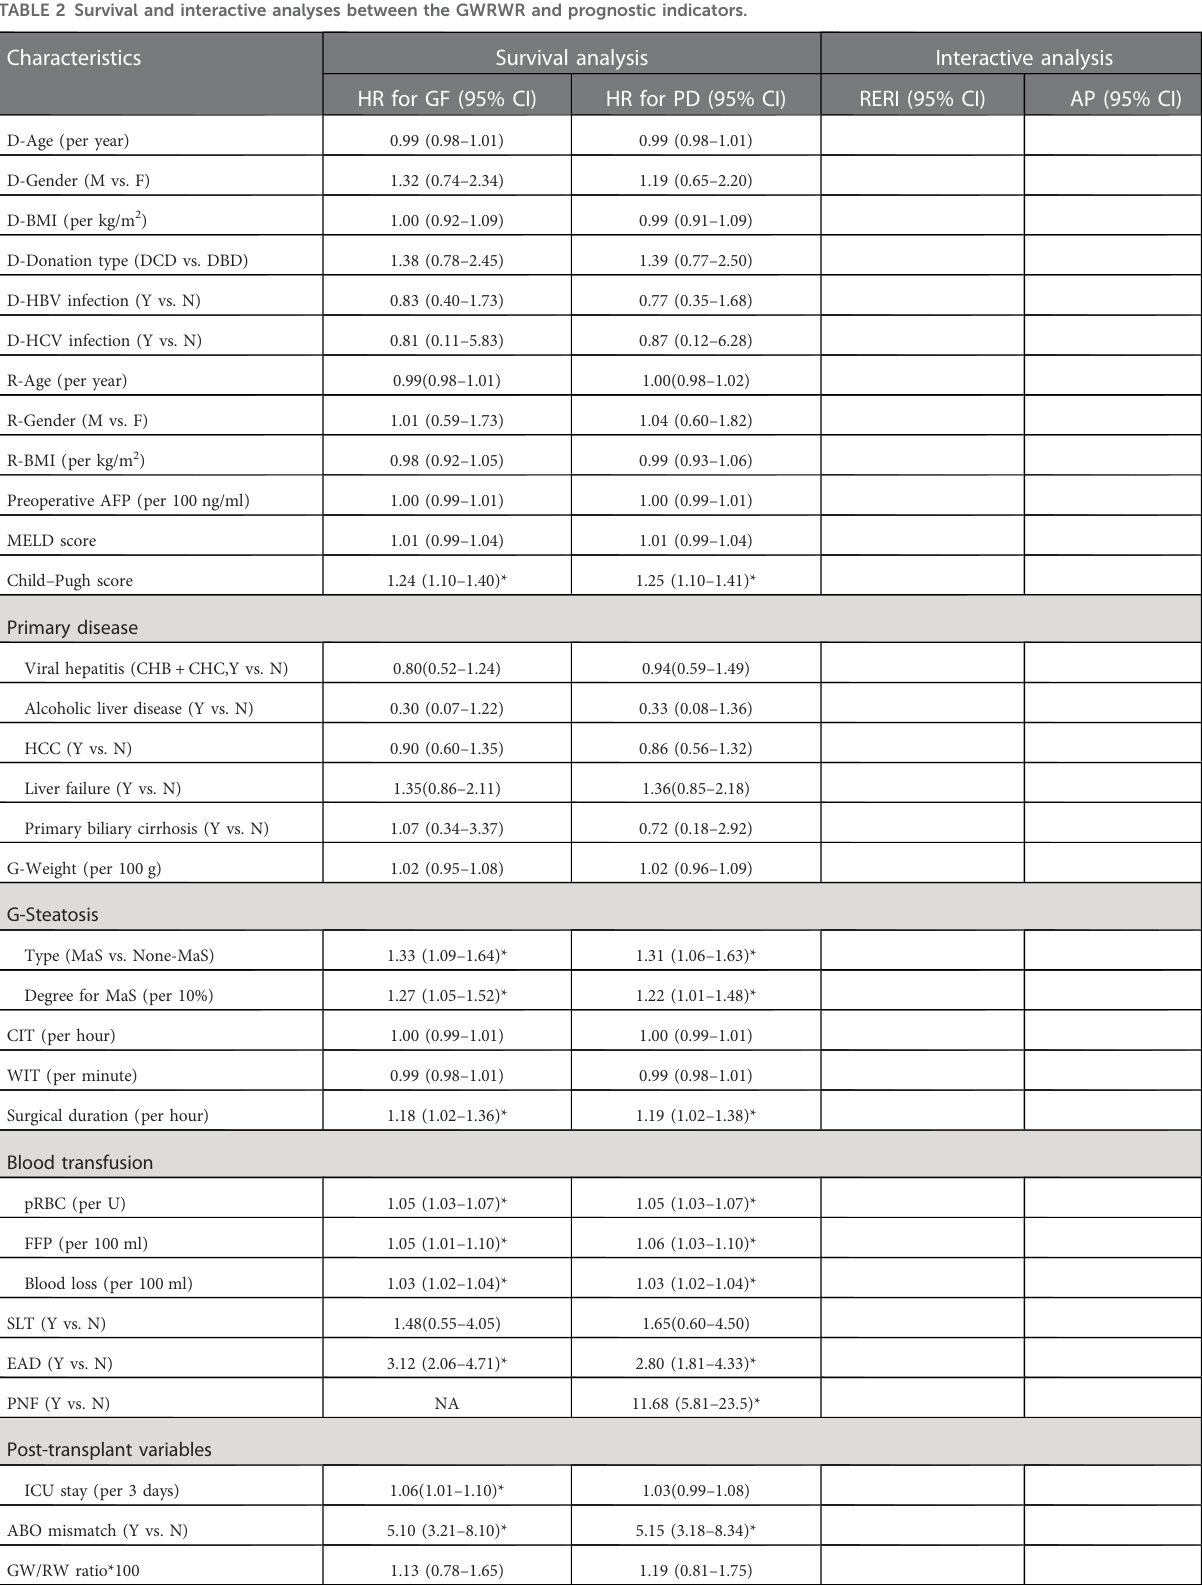
TABLE 2 Survival and interactive analyses between the GWRWR and prognostic